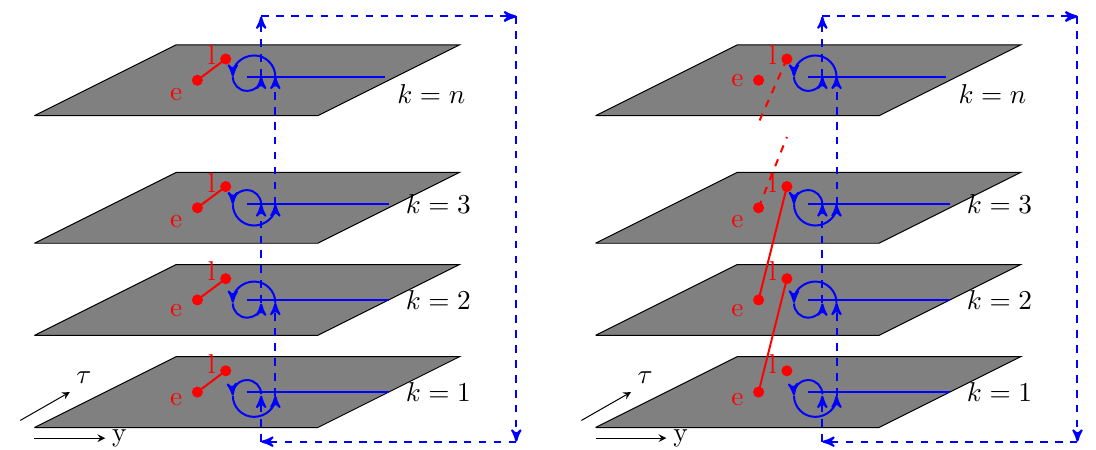
Figure 3 . The leading Wick contractions in the 2 n point function on Σ n . For t < y 0 , only the Wick contractions on the same sheet as shown in the figure on the left contributes. For t > y 0 , both the Wick contractions, that is the one on the same sheet as well as the cyclic Wick contractions along adjacent sheet contributes equally. In the figure on the right, the operator at ‘ e ’ on the last sheet is contracted with the operator at ‘ l